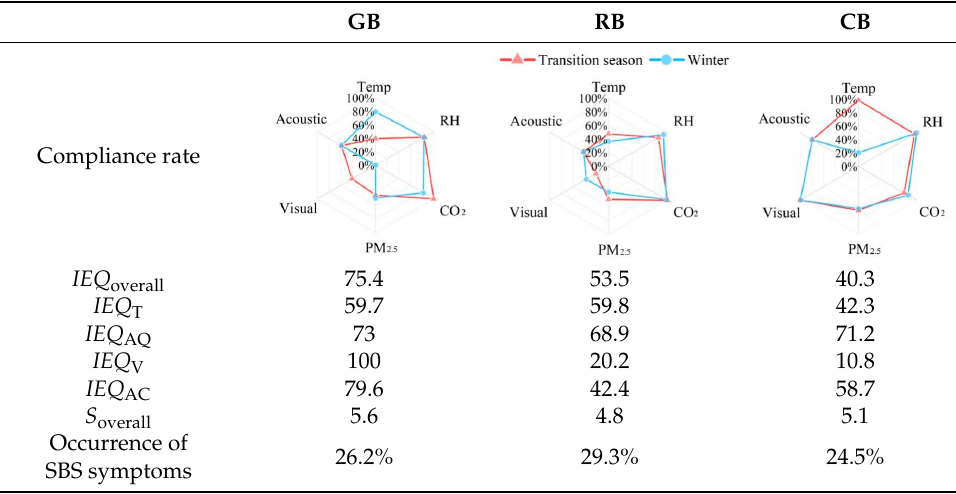
Table 13. Comparison of satisfaction, IEQ, and occurrence of SBS symptoms.